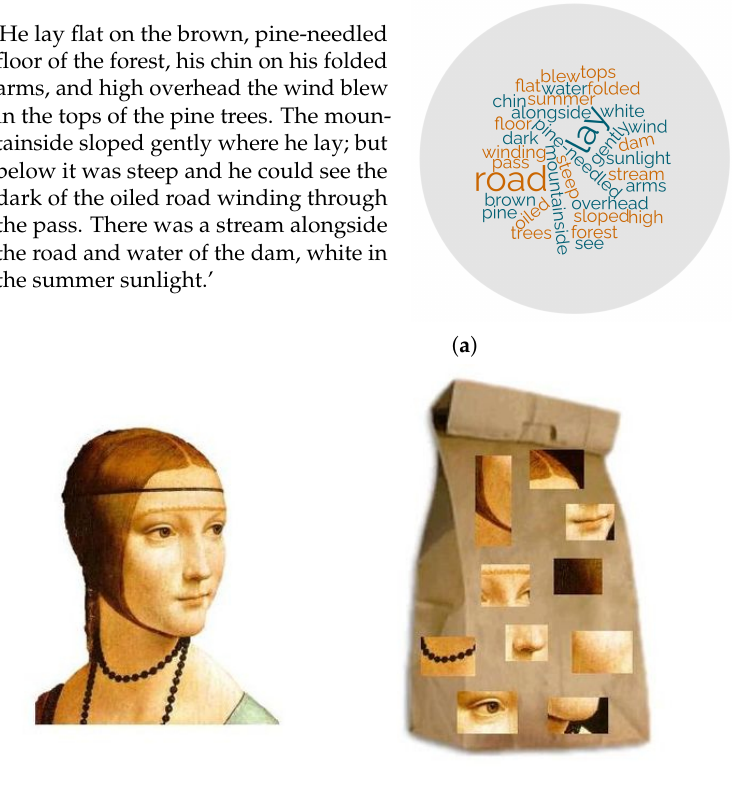
Figure 9. The BoW and BoVW models. ( a ) An illustration of the bag-of-words model: original text ( left ) and bag of words ( right ). Original text from ([79], p. 3); word cloud generated with https: //www.wordclouds.com/ accessed on 9 November 2021. ( b ) An illustration of the bag-of-visual- words model: source image ( left ) and bag of visual words ( right ). Images sourced from Wikimedia Commons (https://upload.wikimedia.org/wikipedia/commons/thumb/0/08/Bag_of_words.JPG/ 640px-Bag_of_words.JPG accessed on 17 June 2021) (Public